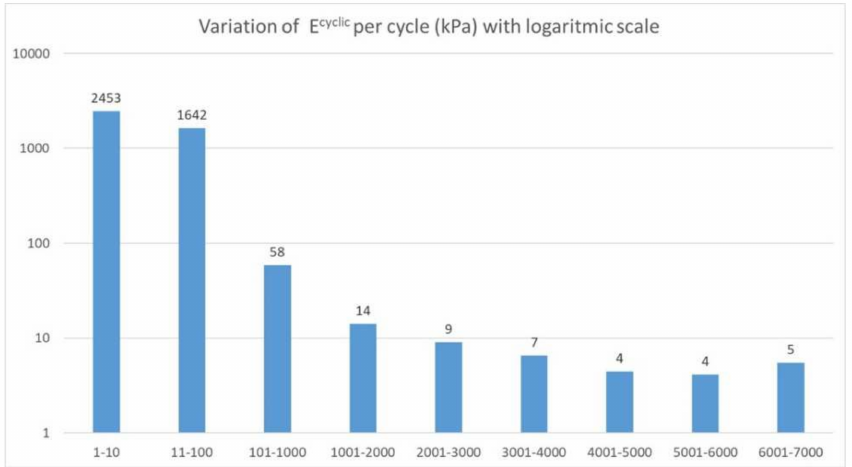
Figure A4. Variation of mean E cyclic per cycle in Cycles 1–10; Cycles 11–1000; and Cycles 1000–2000; and in 1000 cycle intervals